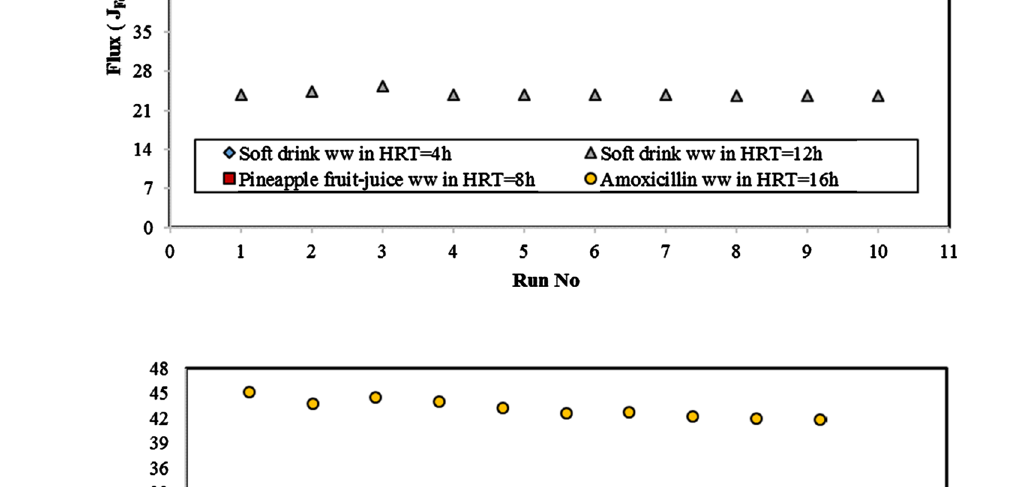
Fig. 11 The results of J during intermittent filtration of MF membrane at constant pres- sure of 15 psi for three types of wastewater